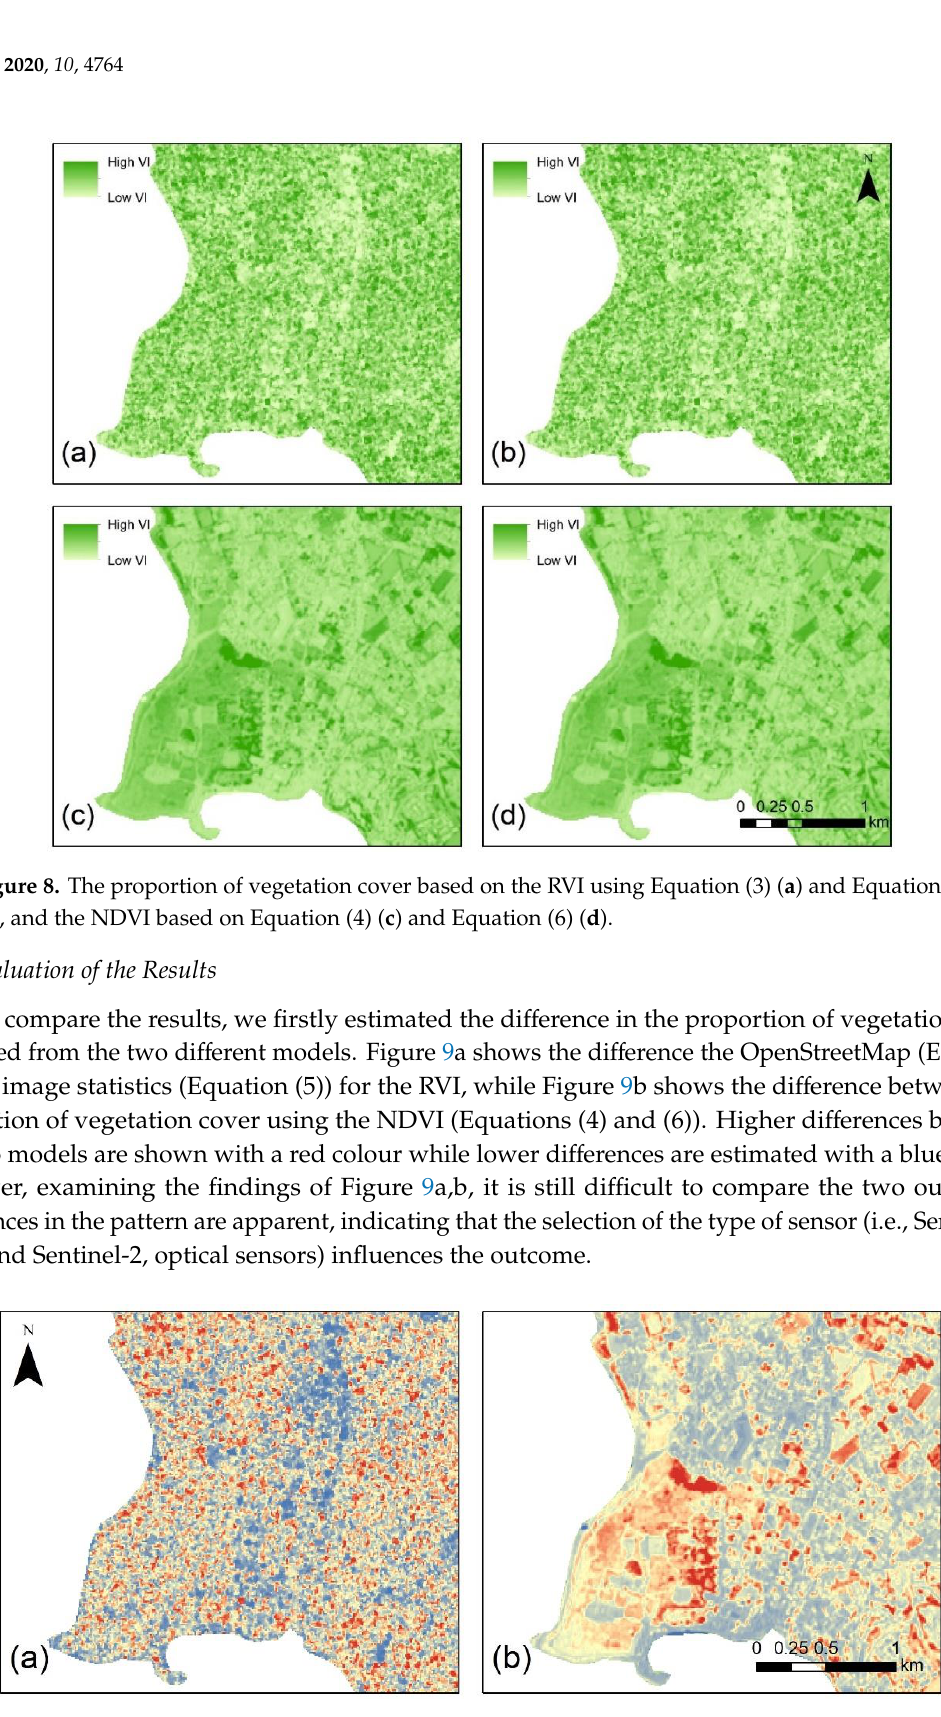
Figure 9. ( a ) Difference of the proportion of vegetation cover as estimated from the Radar Vegetaton Index (RVI) based on Equations (3) and (5) and ( b ) Difference of the proportion of vegetation cover as estimated from the Normalized Difference Vegetation Index (NDVI) based on Equations (4) and (6). Higher difference values are indicated with red colour, while lower values with blue colour.